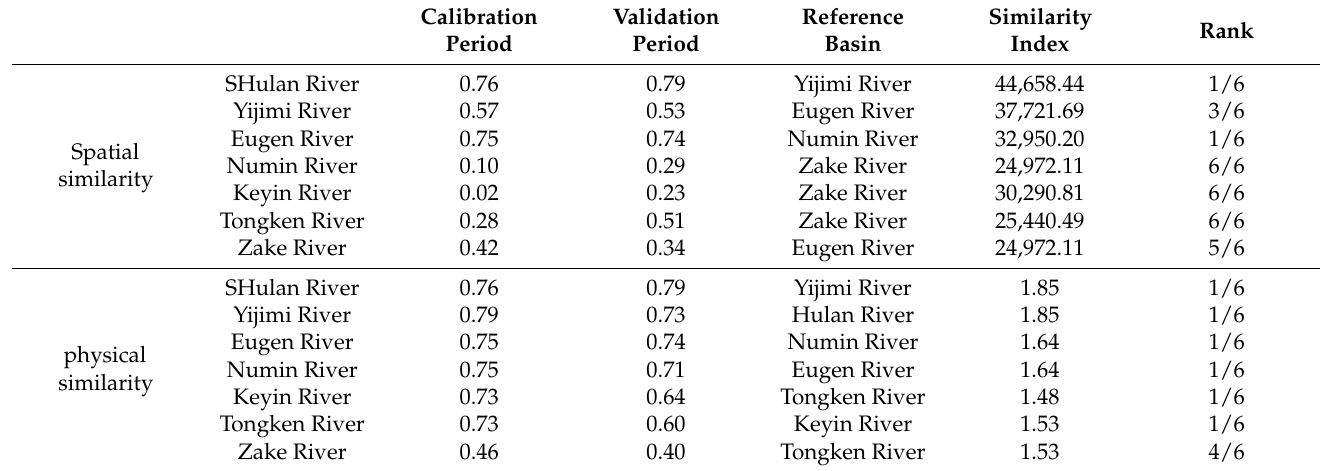
Table 5. Parameter transfer efficiency of the Hulan River Basin based on physical similarity and spatial similarity.